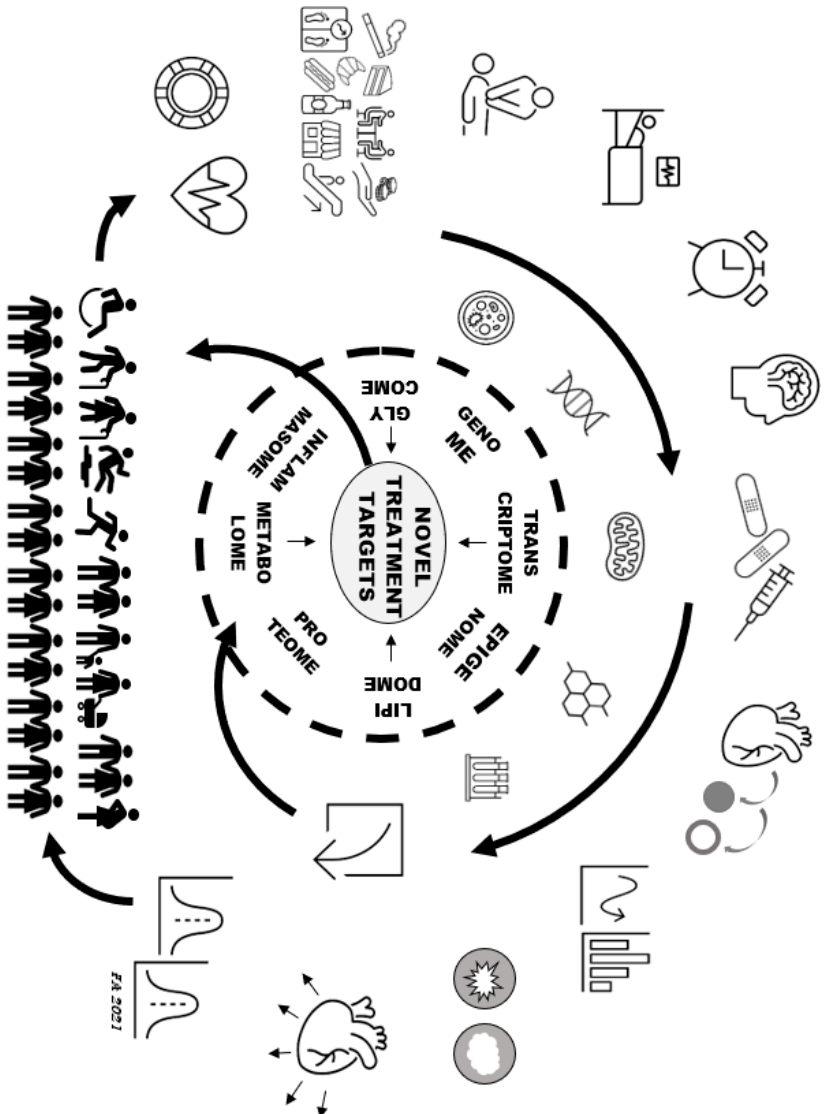
Figure 1. Deep precision mapping of ACS phenogroups. Outer circle: patients may be immediately stratified on the basis of non-omic features, such as age, sex, transient or persistent chest pain, ECG changes, suspected vasospasm, risk factor exposure, cardiac arrest, time of day of clinical onset, preinfarction angina, response to therapies, underlying plaque fissure or erosion, prothrombotic/inflammatory conditions, or adverse myocardial remodeling. Inner circle: biomolecular omic interrogation of the above different phenogroups is bound to expand knowledge of underlying mechanisms. Atypical presentations (tails of frequency curves) may reveal yet unrecognised forms of disease. Modified from [16]. ACS: acute coronary syndromes. Table 1. Tools and challenges of ACS precision medicine.